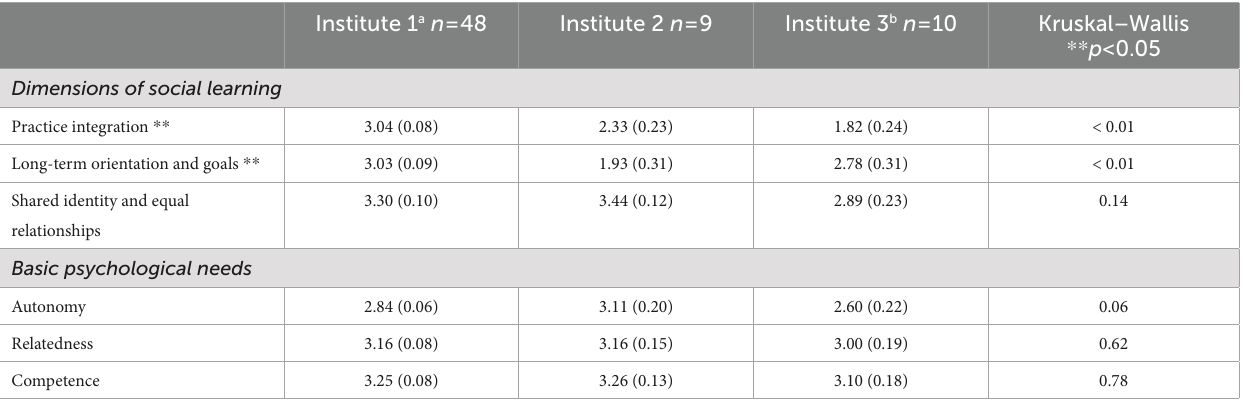
TABLE 7 Descriptive statistics for social configurations and basic psychological needs for Institutes 1, 2, and